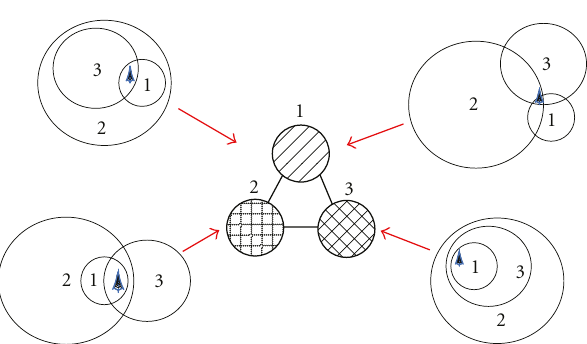
Figure 2: System model.